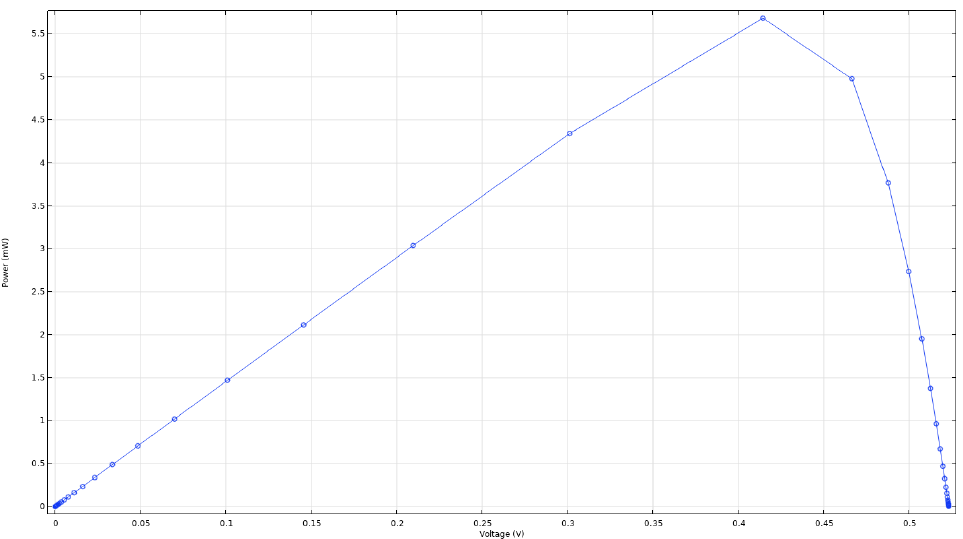
Figure 15. P-V curve of the solar cell with voltage (V) on the horizontal axis and power (mW) on the vertical